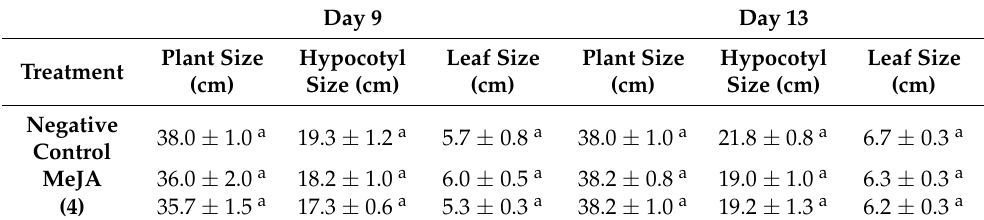
Table 2. Effect of spraying with 1-oxo-indanoyl-L-isoleucyl methyl ester ( 4 ) and MeJA on growth of common bean seedlings ( P. vulgaris L. cv. Uribe Rosado). Ten seedlings were used each day; all values are presented as mean ± standard